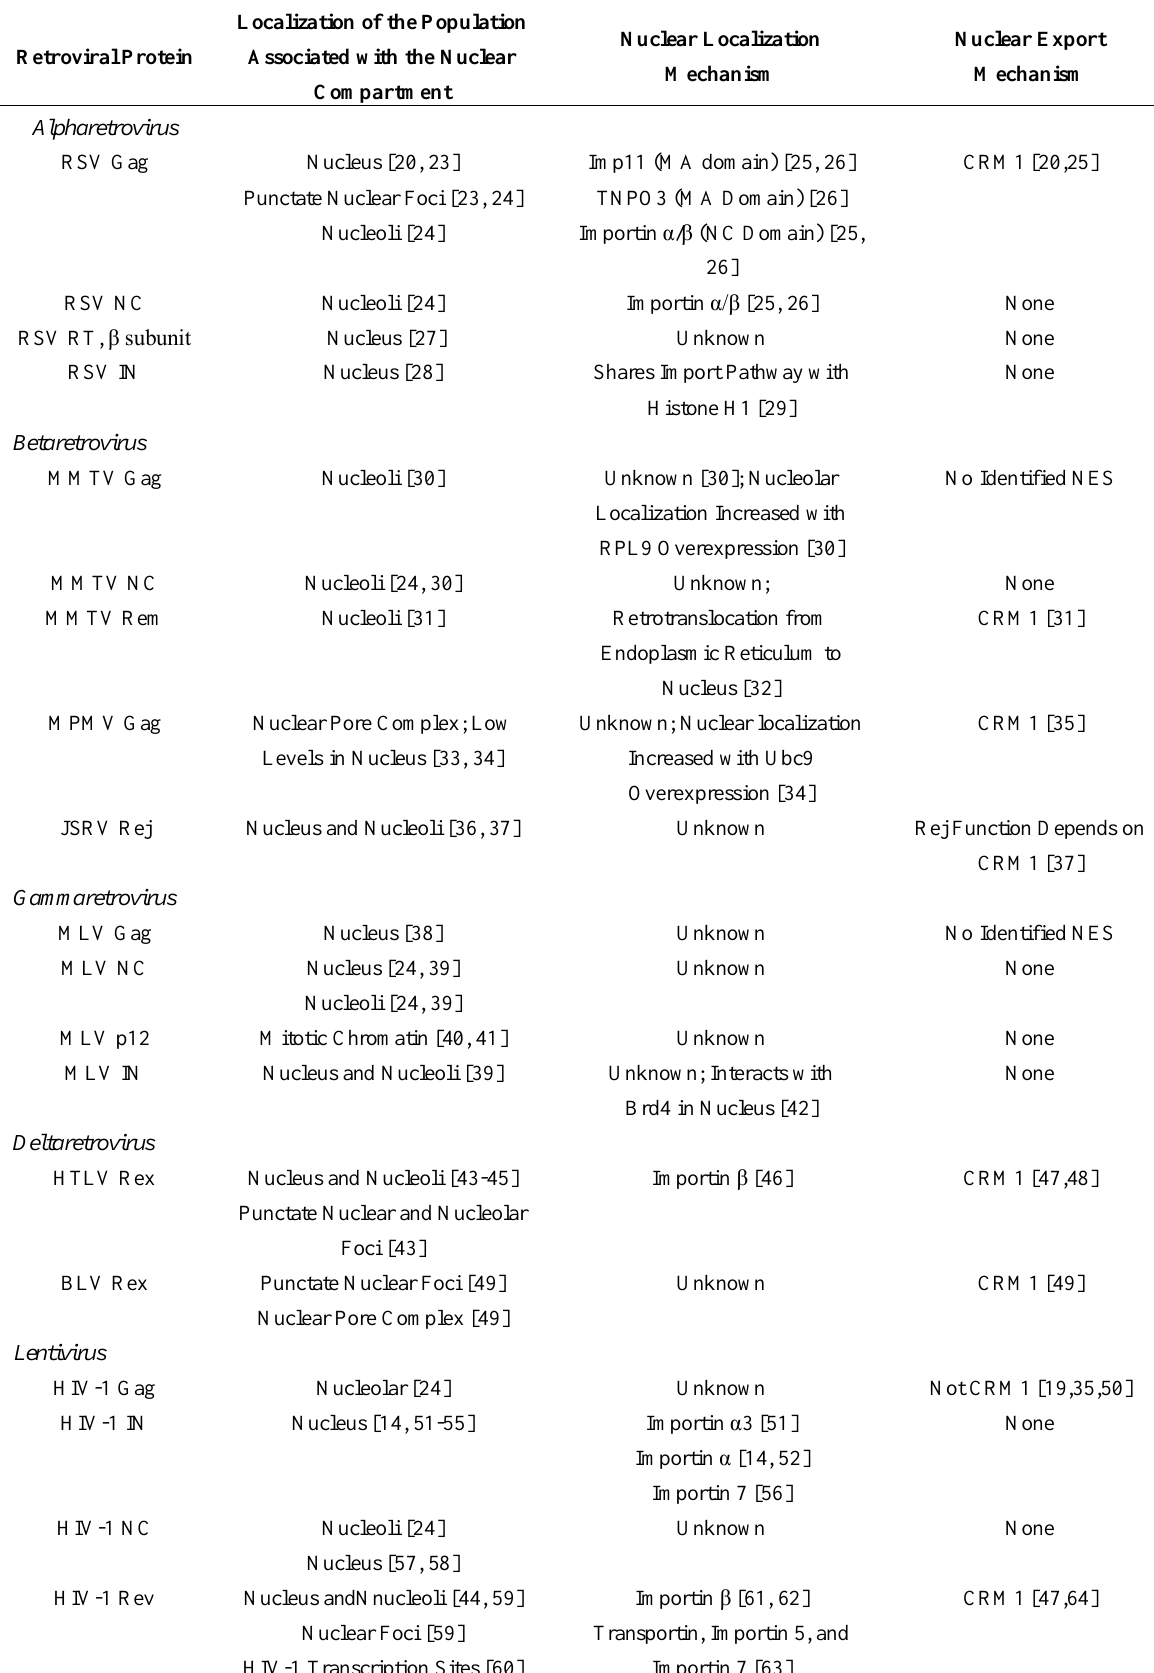
Table 1. Retroviral proteins that undergo nuclear trafficking* Retroviral